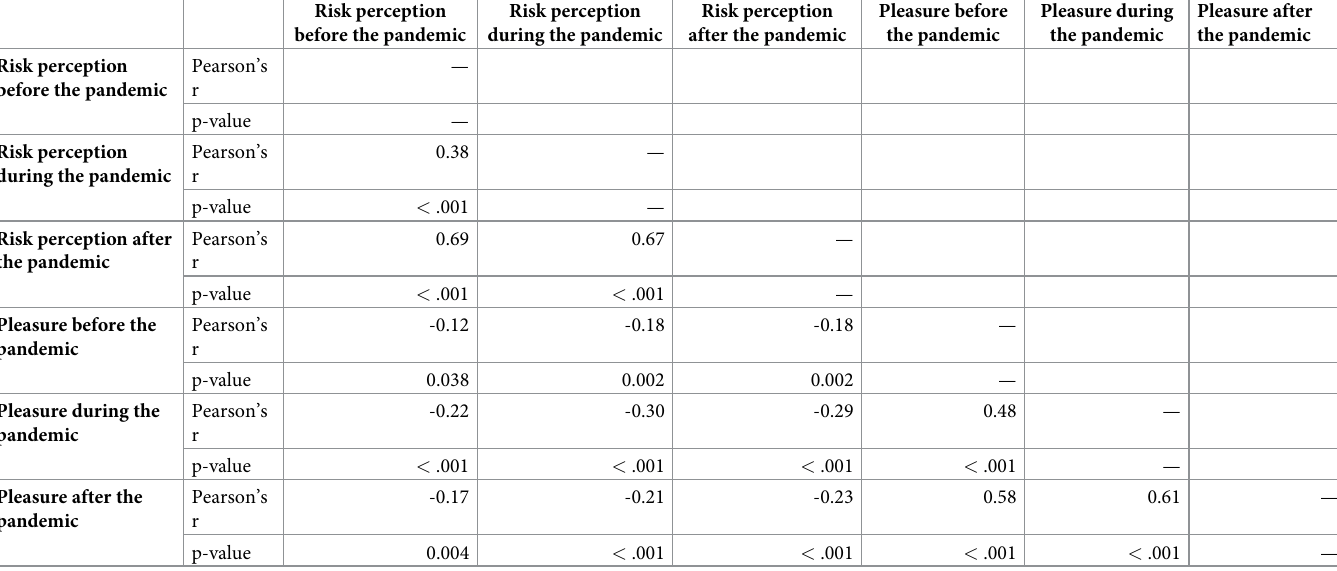
Table 10. Pearson’s correlation matrix among risk-perception measures and STS pleasure dimension over time.